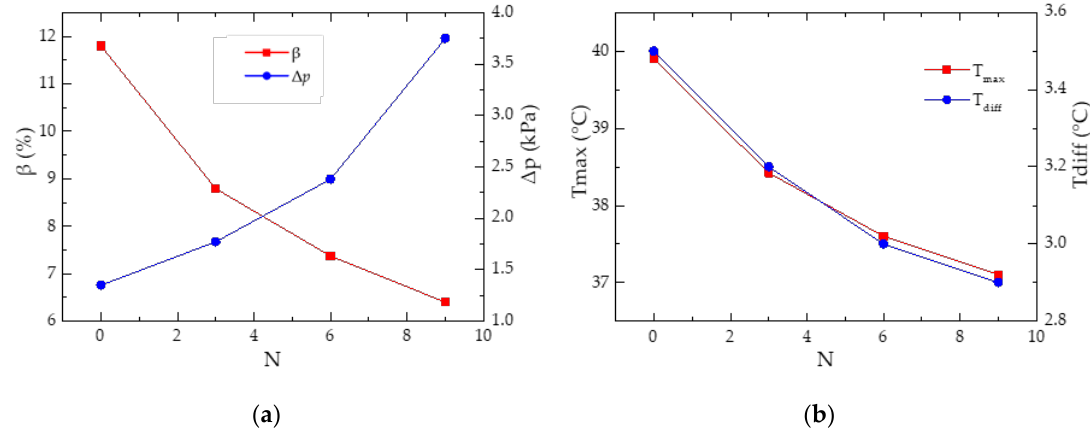
Figure 11. The effect of N on several parameters at Q = 5 L/min, δ = 0.973: ( a ) β and Δ p ; ( b ) T max and T diff .